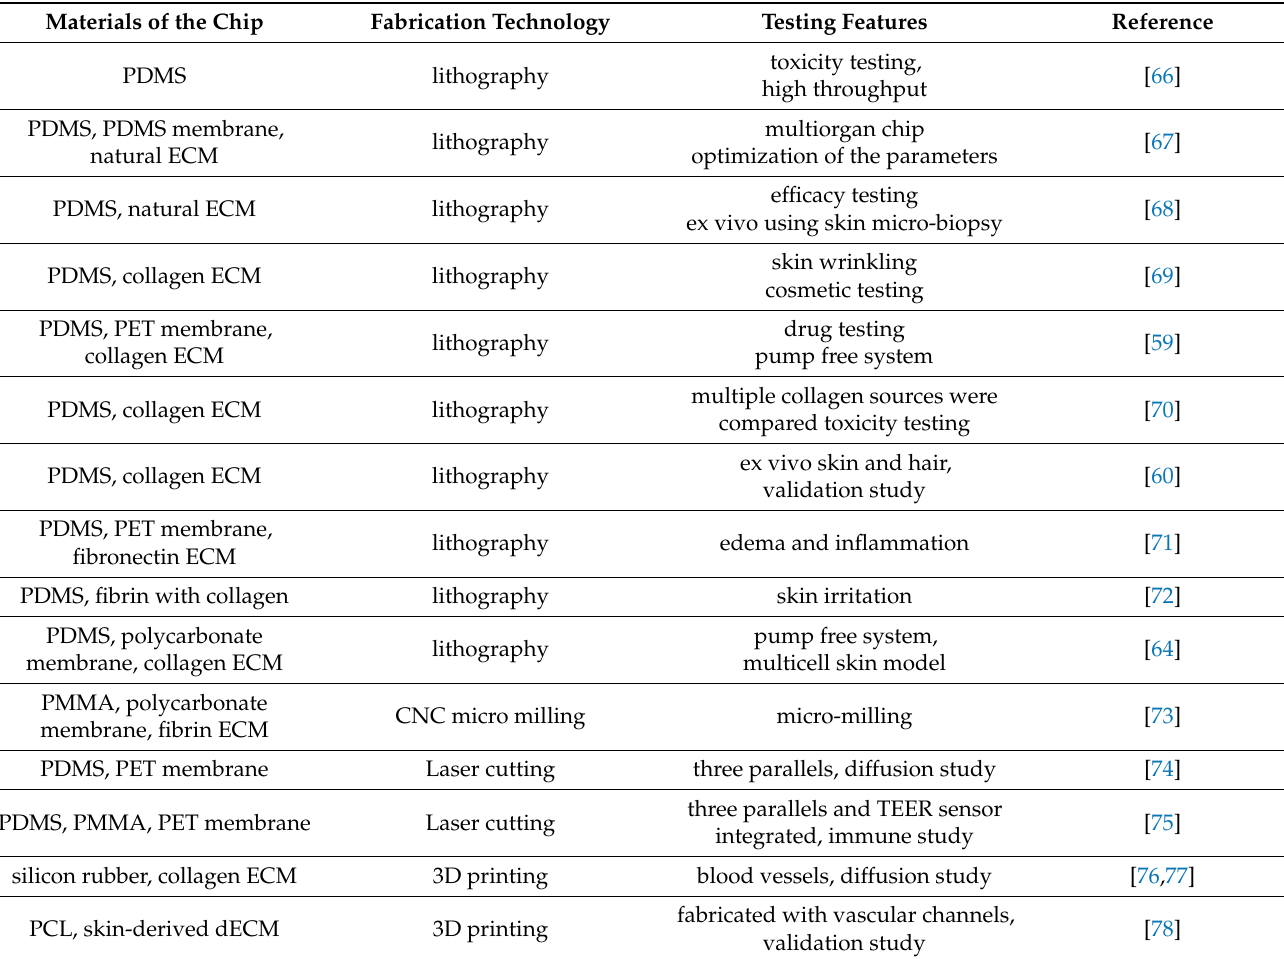
Table 6. Characteristics of different skin-on-a-chip systems in the literature (modified from Sutterby and co-workers, 2020 [65]). PDMS: Poly(dimethylsiloxane), ECM: Extracellular matrix, PET: Polyester, PMMA: Polymethylmethacrylate, PCL: Polycaprolactone, dECM: Dermal extracellular